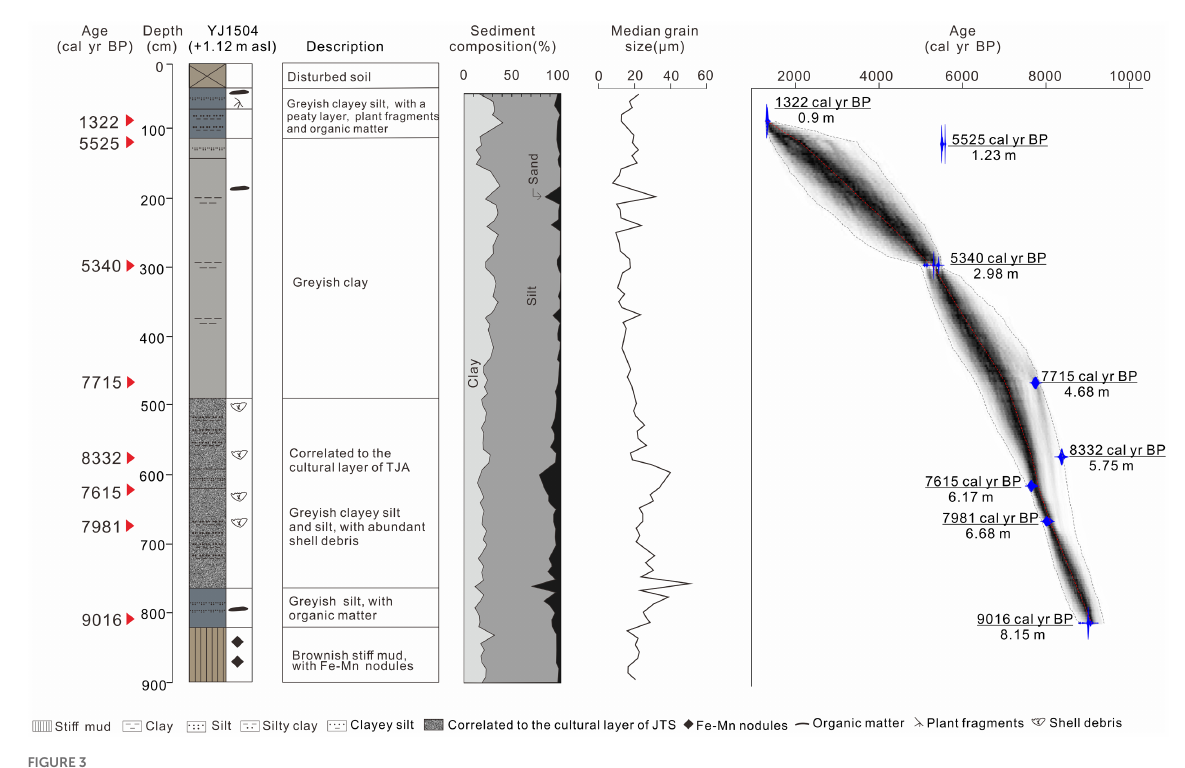
FIGURE 3 Sediment lithology, grain-size distributions and age model of core